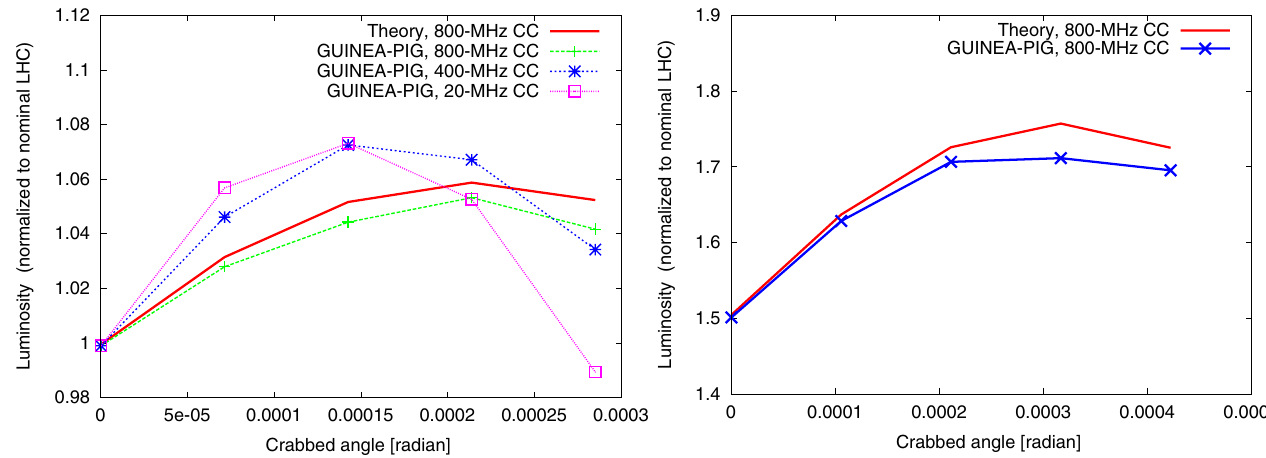
FIG. 15. (Color) Relative luminosity gain (normalized to the case without crab cavity) versus crabbing angle at IP5, for the nominal LHC collision optics (left) and for the lowbetamax collision optics (right) with a single global crab cavity. A luminosity gain of 7% or 25% is achieved, respectively. For 20 MHz the optimum crab angle equals half the crossing angle as theoretically expected while this is no longer the case for the higher crab frequencies due to the rf